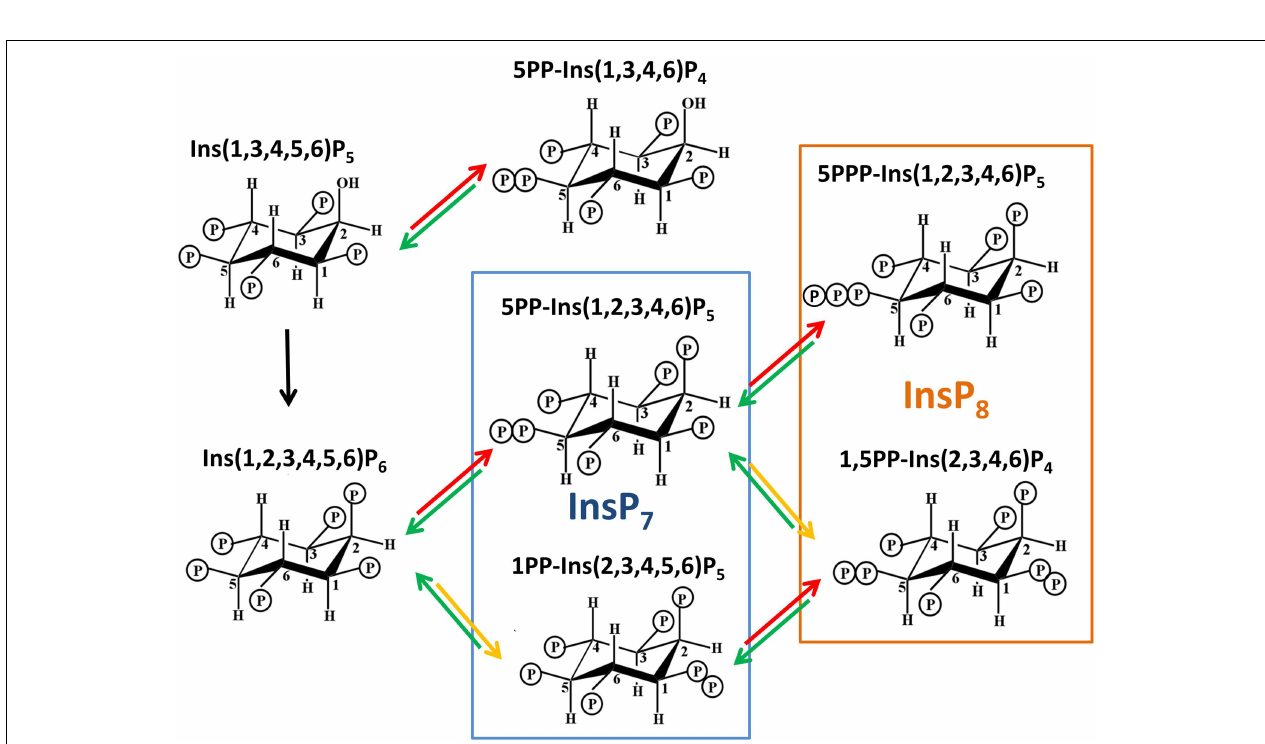
species are indicated in black and key enzymes are indicated in brown. A more detailed outline of PPx-InsP synthesis is depicted in Figure 2 . The blue and orange asterisks correspond to the colored boxes in Figure 2 .